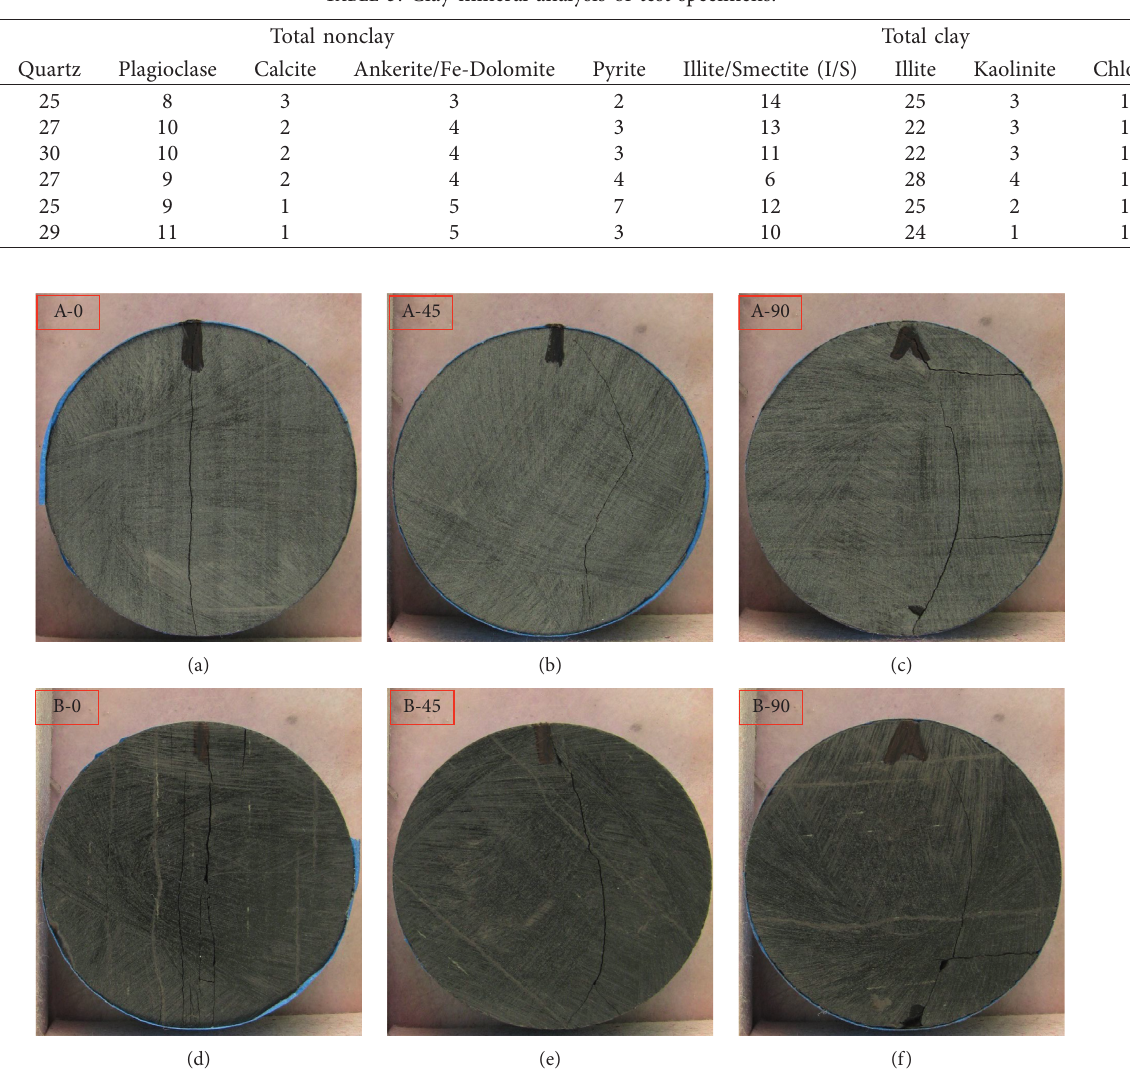
Figure 8: Split form of test specimen. (a) A-0. (b) A-45. (c) A-90. (d) B-0. (e) B-45. (f)